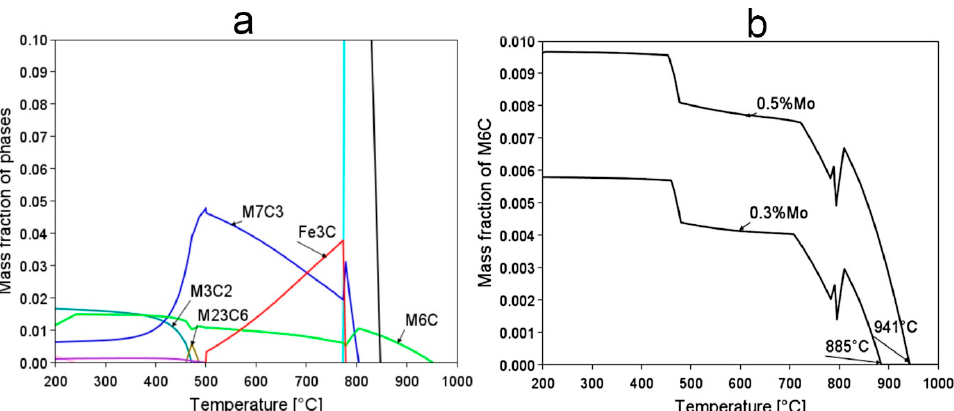
Figure 4. ( a ) Calculated fraction of carbide phases as a function of temperature of steel 0.5C-2.0Si- 1.5Cr-0.5Mn-0.2V-0.45Al-0.5Mo. ( b ) Comparison of the M 6 C carbide dissolution temperature for the two Mo contents of 0.3 wt.% and 0.5 wt%. Thermocalc, database version TCFE11.